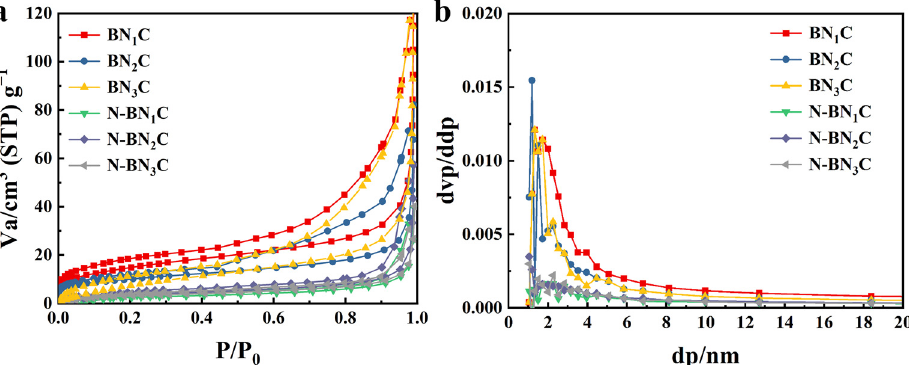
Figure 4. N 2 adsorption–desorption isotherms ( a ) and pore diameter distribution ( b ) of BN x C and N-BN x C (x = 1, 2, 3, corresponding to MBA:AM = 1:1, 1:2, 1:3, respectively). Table 1. Pore structure and nitrogen content of BN x C and N-BN x C.